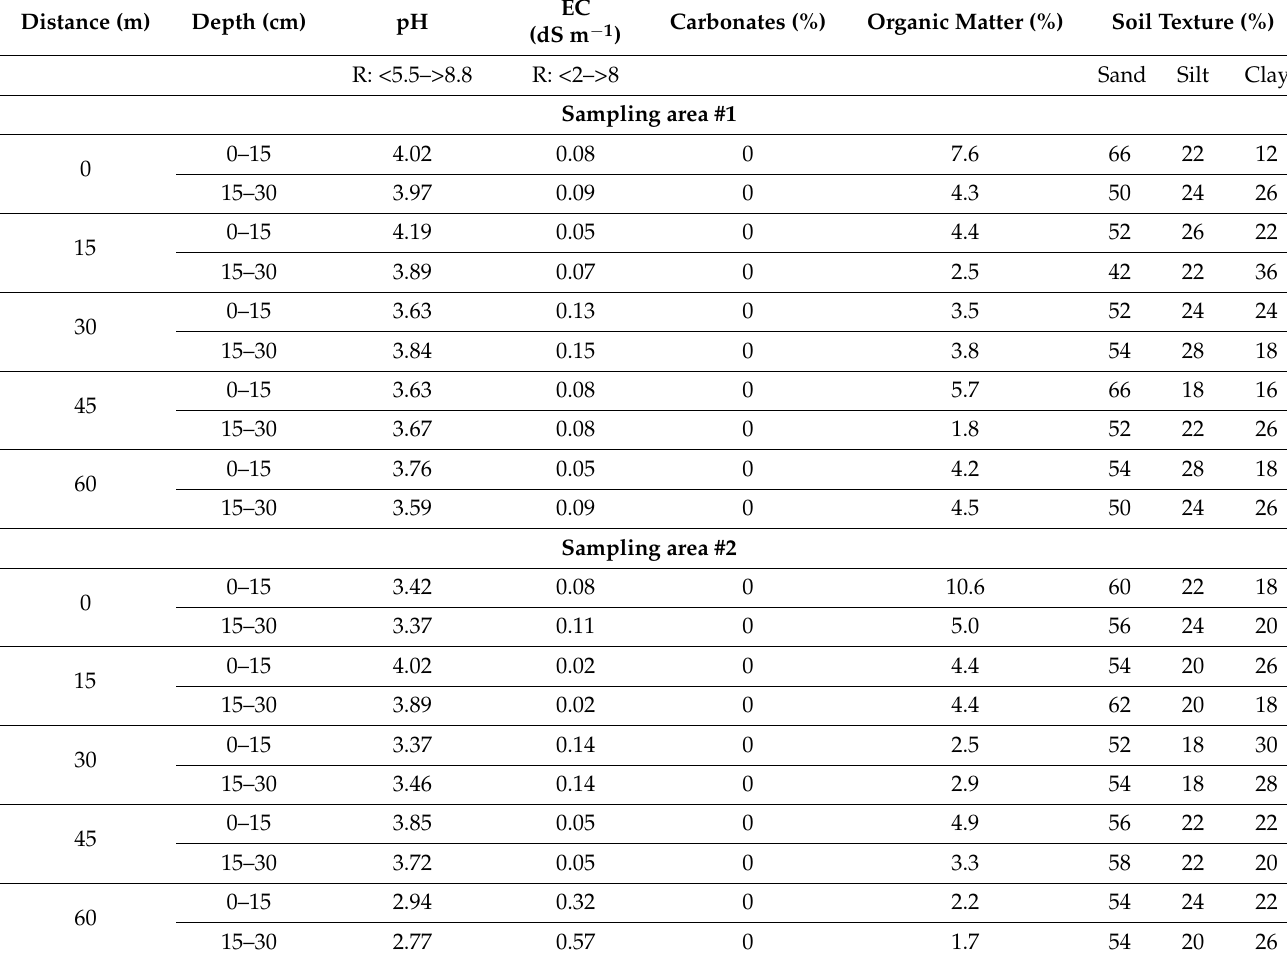
Table 1. Properties of soil samples from Hualgayoc district, Cajamarca region,